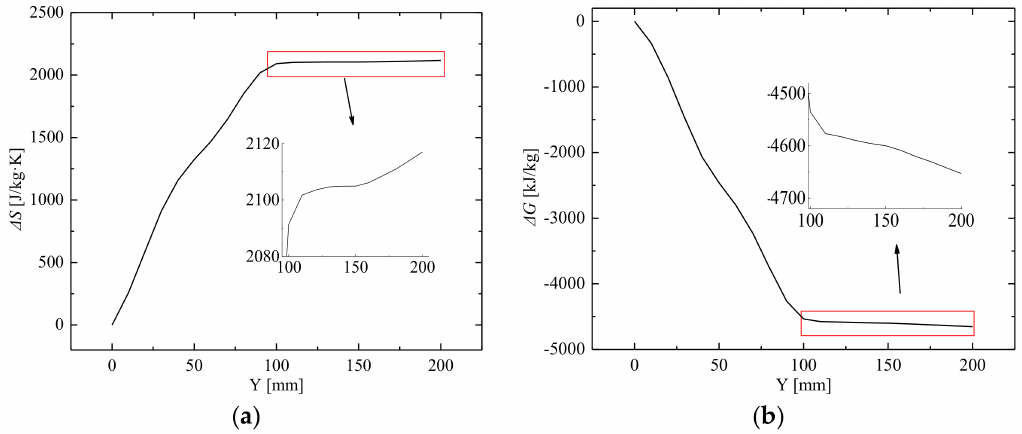
Figure 9. ( a ) ∆ S and ( b ) ∆ G of the CRD combustor cross-section in the axial